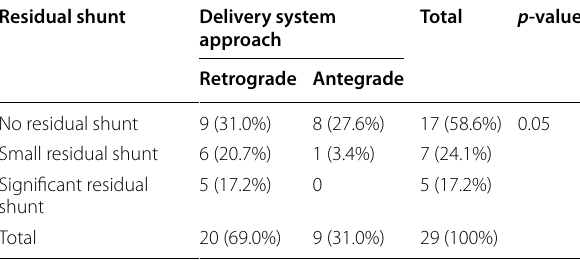
Table 2 The association between residual shunt and delivery system